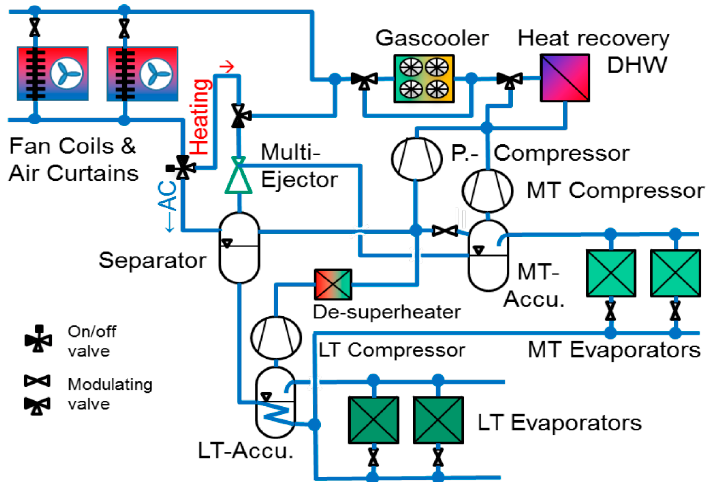
Figure 8. Integration of direct heating and cooling fan coils and air curtains in a transcritical R744 supermarket refrigeration system (multi-ejector block partly by-passed in AC mode) [40].